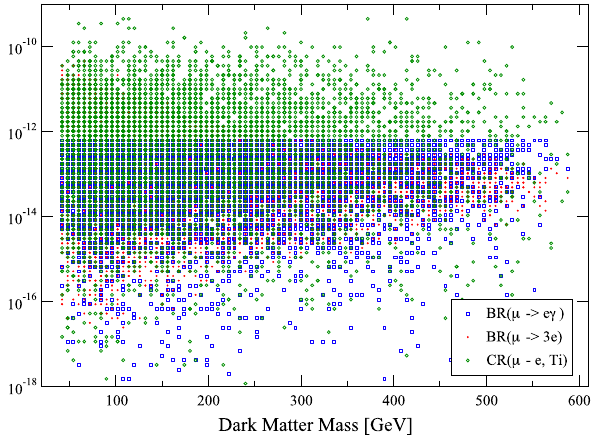
Fig. 7 The rates of the most relevant μ – e LFV processes as a function of the dark matter mass for our sample of viable models